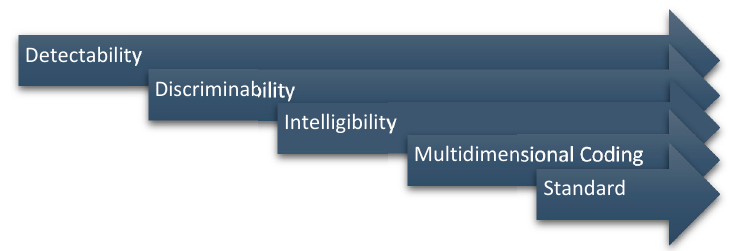
Figure 1. Good Information Coding System Framework.